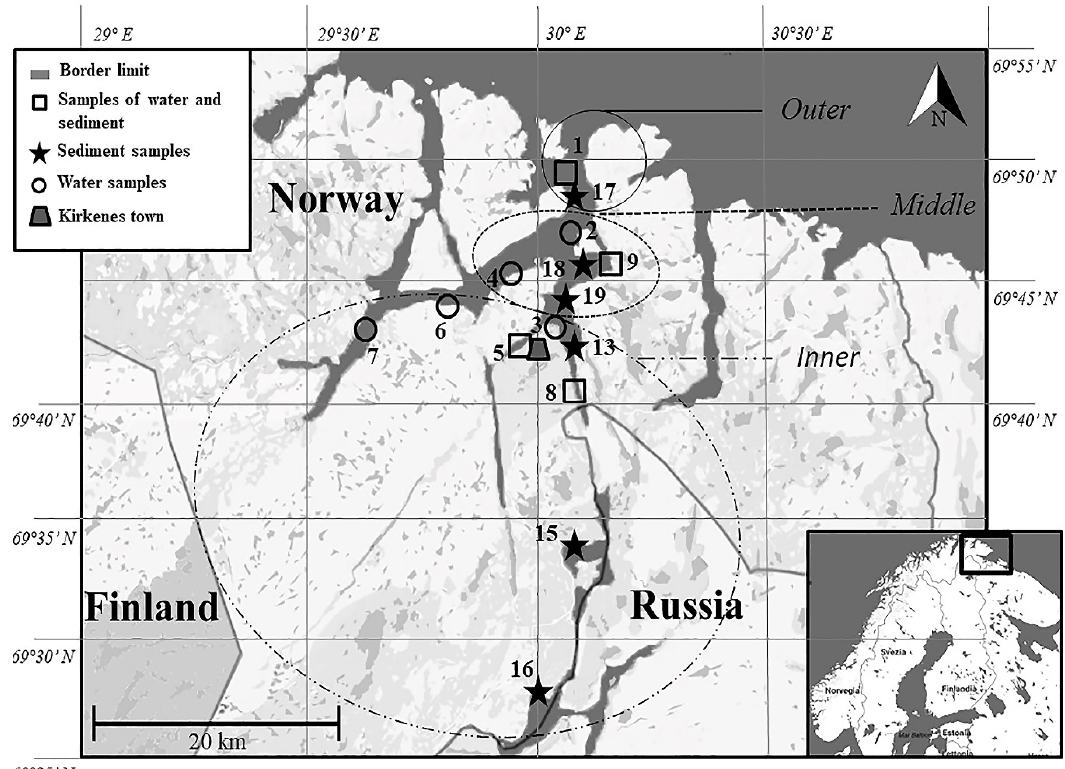
Figure 1. Location of the sampling sites along the Pasvik River.